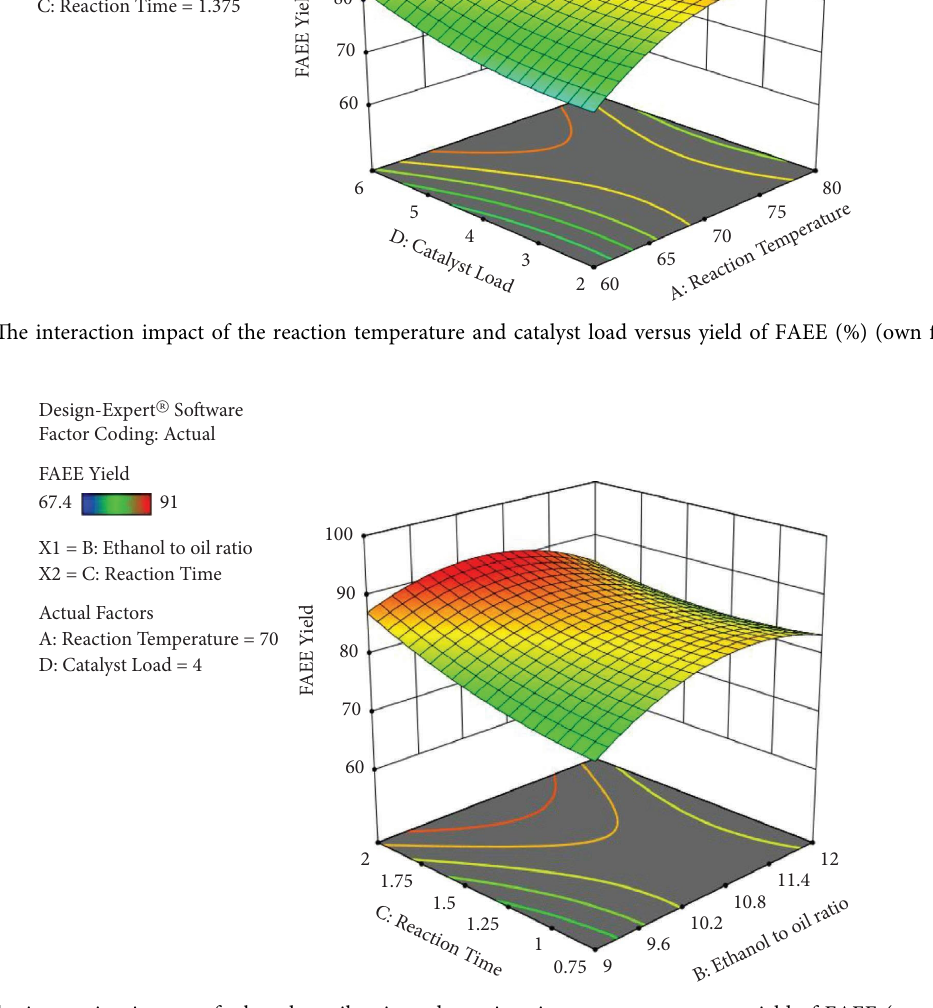
Figure 9: Te interaction impact of ethanol to oil ratio and reaction time versus percentage yield of FAEE (own fgure). Table 3: Summary of physicochemical properties of C.M. seed oil-based biodiesel with standards [30].